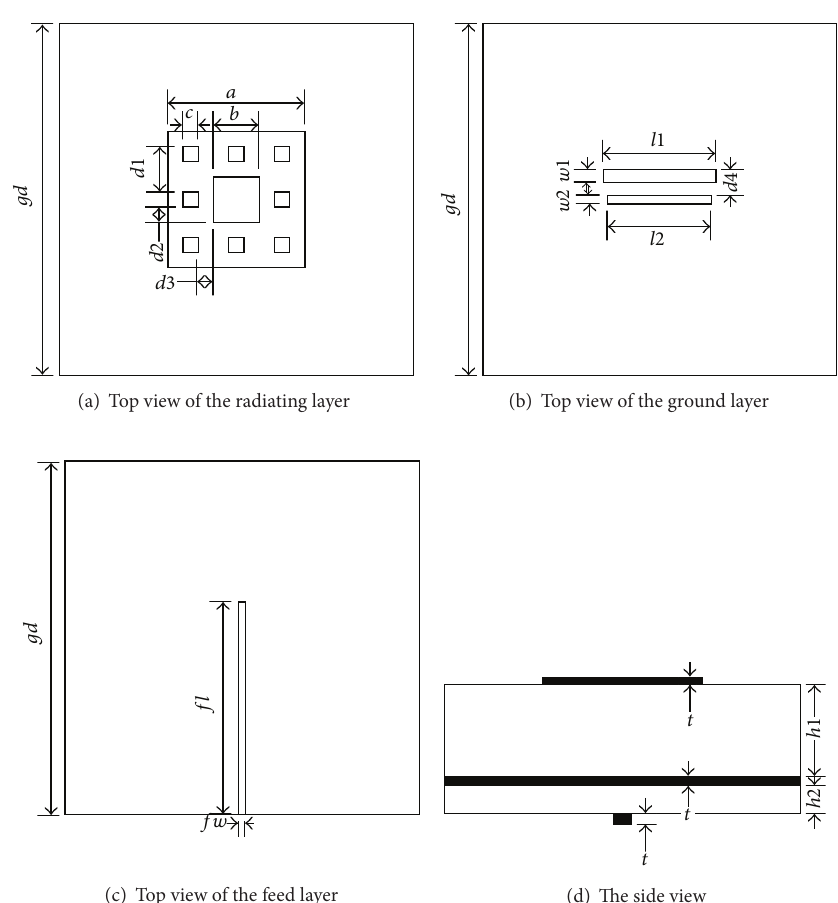
Figure 2: Geometry of the modified aperture coupled Sierpinski patch antenna. (a) Top view of the radiating layer. (b) Top view of the ground layer. (c) Top view of the feed layer. (d) The side